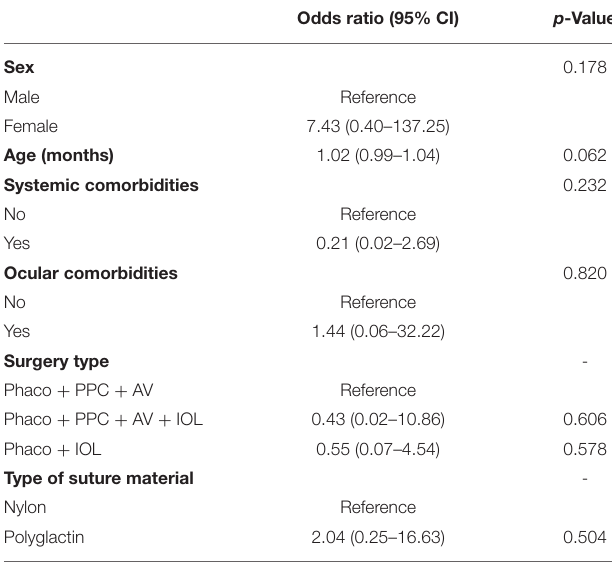
TABLE 3 | Multiple logistic regression analysis applied to data on intraoperative complications in pediatric cataract surgeries in which either nylon or polyglactin sutures were used. Odds ratio (95%